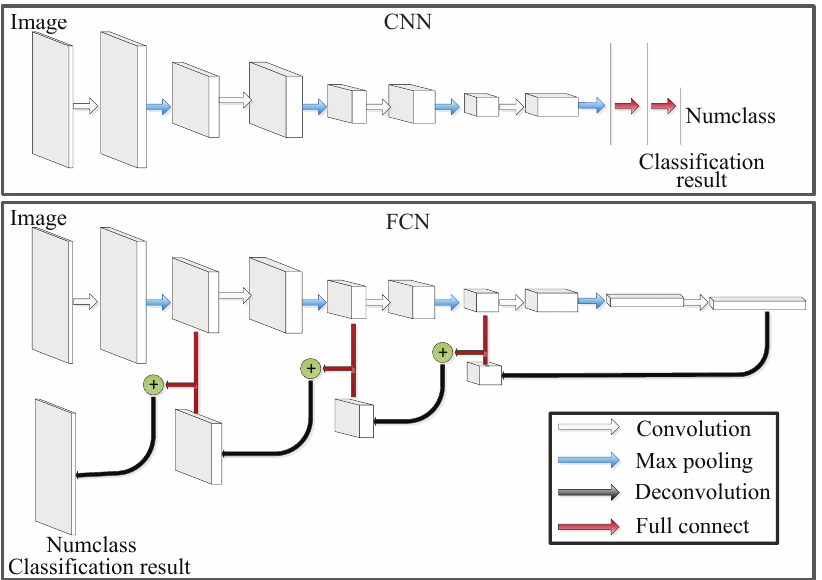
Figure 1. FCN transforms fully connected layers into convolutional layers so that an efficient classification net for end-to-end dense learning can be